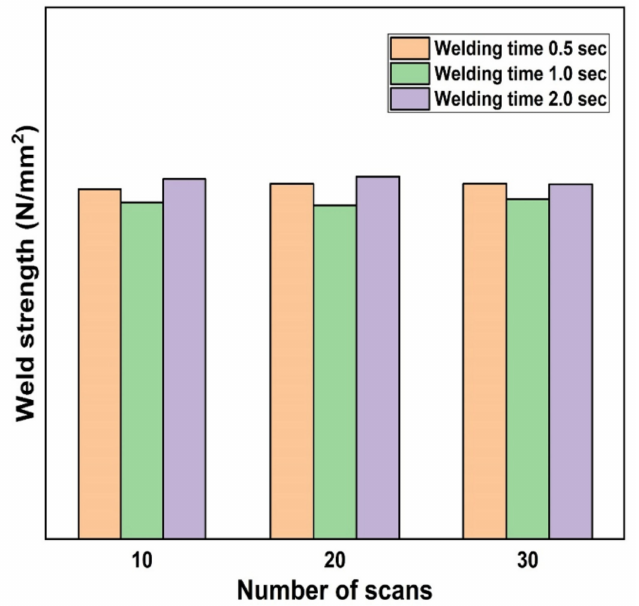
Figure 13. The effect of welding time on the weld strength with varying number of scans in case of diode laser